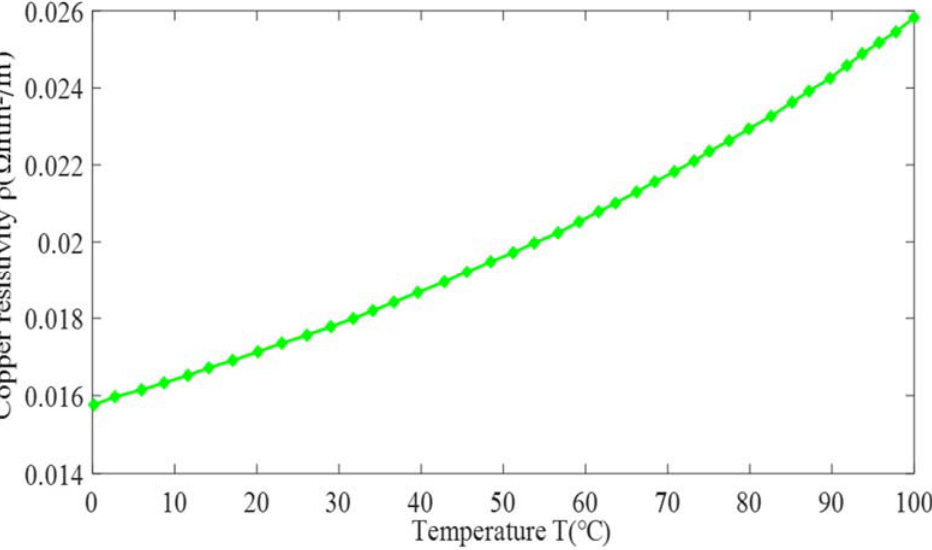
Figure 8. Copper resistivity variation with temperature. Energies 2021 , 14 , x FOR PEER REVIEW 11 of 17 Based on the LPTN of IPMSM in Figure 7b and Equations (7)–(13), transient node temperature curves of the main heat sources are given in Figure 9.